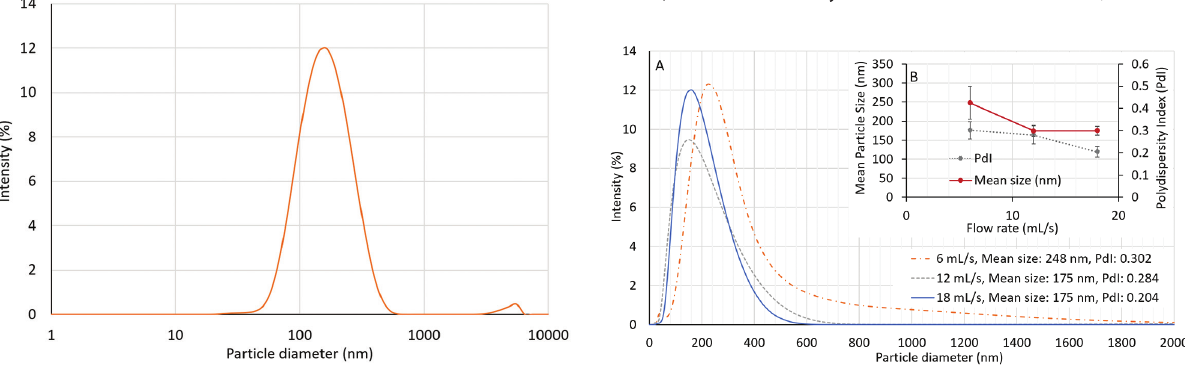
Figure 4: Effect of flow rate at 1200 rpm, 9:1 antisolvent to solvent ratio, on the grooved disc (a) PSD, (b) plot of mean particle size and